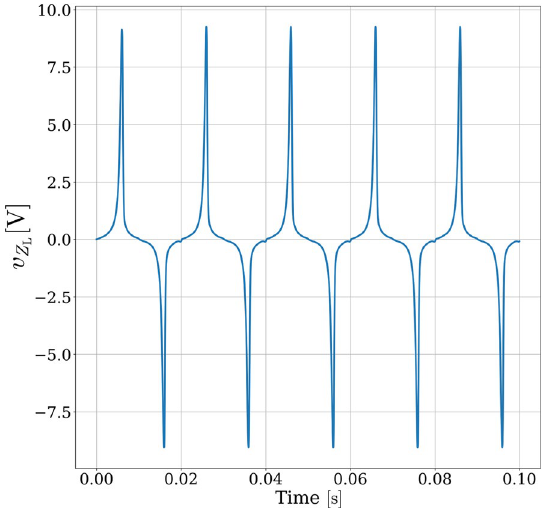
Fig. 16 Voltage across the series of resistor R L and inductor L L